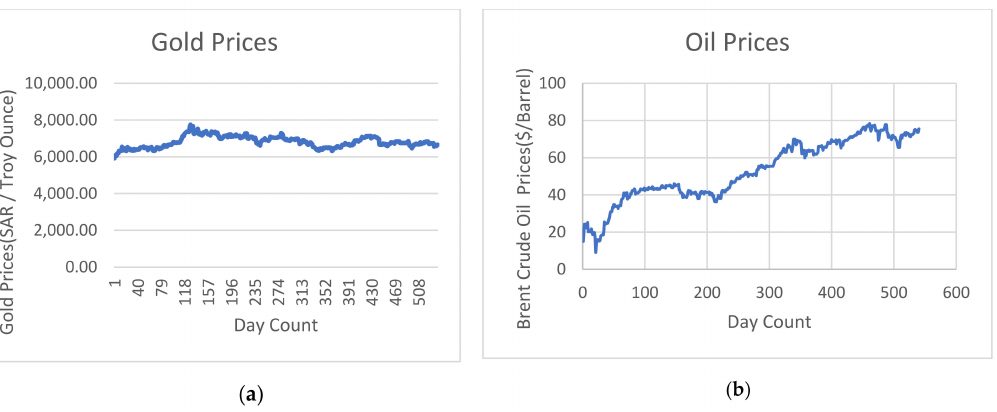
Figure 5. Plots of the Gold/Oil prices versus 540 Days under the COVID-19 Pandemic; ( a ) Gold prices; ( b ) Oil